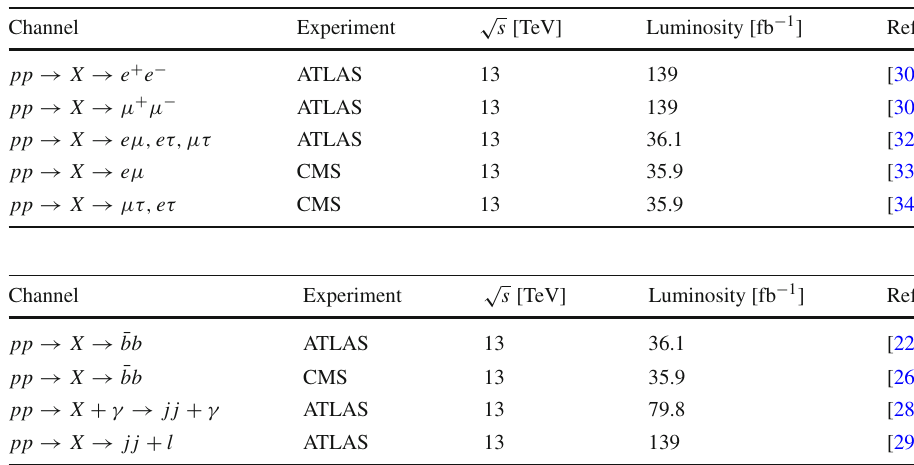
Table 1 List of experimental searches for BSM resonances decaying into a di-lepton final states newly implemented into HiggsBounds